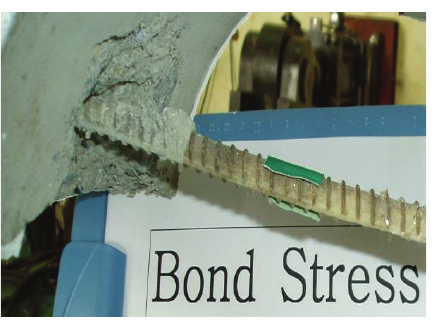
Figure 7: Pullout